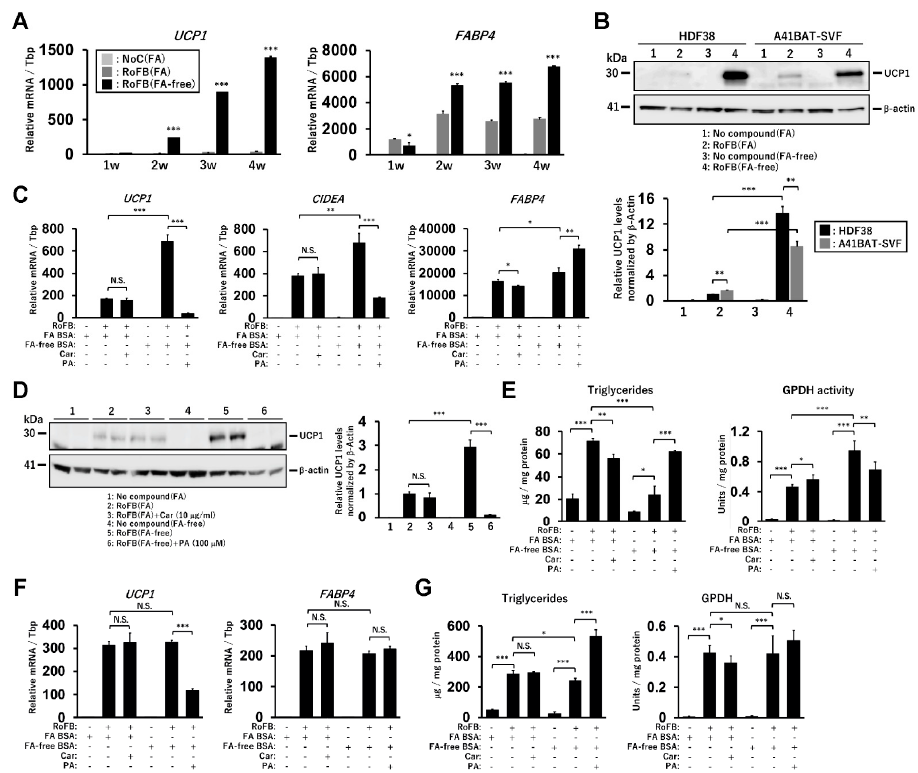
Figure 5. Regulation of UCP1 expression by FAs in an immortalized human-brown-preadipocyte cell line (hTERT A41BAT-SVF). ( A ) The expression of UCP1 and FABP4 was quantified using qRT- PCR during differentiation of A41BAT-SVF preadipocytes using RoFB in the treatment with either FA BSA or FA-free BSA, from 1 to 4 weeks as indicated. ( B ) UCP1 protein levels were compared between ciBAs and A41BAT-SVF adipocytes. ( C ) The expression of UCP1 , CIDEA , and FABP4 was quantified using qRT-PCR in A41BAT-SVF adipocytes differentiated using carnitine or PA. ( D ) The UCP1 protein was immunoblotted in A41BAT-SVF adipocytes differentiated under various condi- tions. ( E ) Cellular triglyceride content and GPDH activity were measured in A41BAT-SVF adipo- cytes. ( F ) The expression of UCP1 and FABP4 was quantified using qRT-PCR in adipocytes differ- entiated from adipose-tissue-derived mesenchymal stem cells (AdMSCs) using carnitine or PA. ( G ) Cellular triglyceride content and GPDH activity were measured in AdMSC-derived adipocytes. Data represent mean ± SD ( n = 3). Student’s t-test: * p < 0.05, ** p < 0.01, *** p < 0.001, N.S.; not signif- icant.